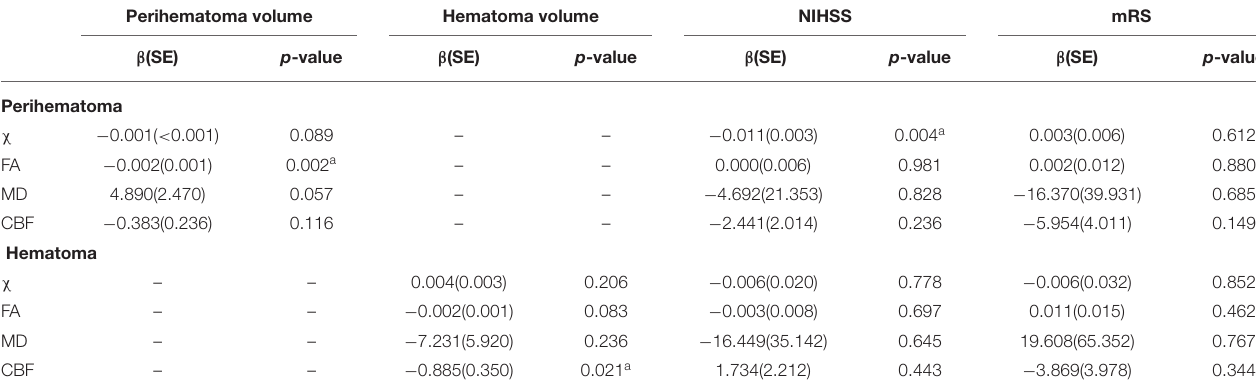
TABLE 2 | Summarized association between imaging measurements within hematoma and perihematomal volumes and clinical scores. Perihematoma